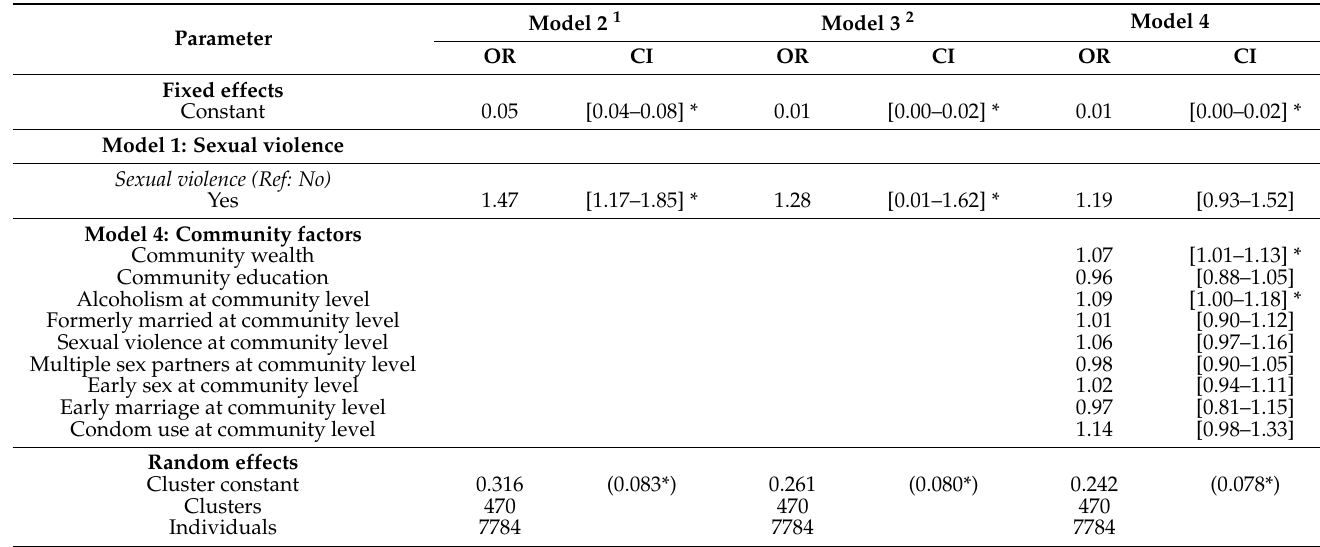
Table 4. HIV prevalence by sexual violence and community-level factors after controlling for indi- vidual level effects, UAIS, 2011 ( n = 7784).